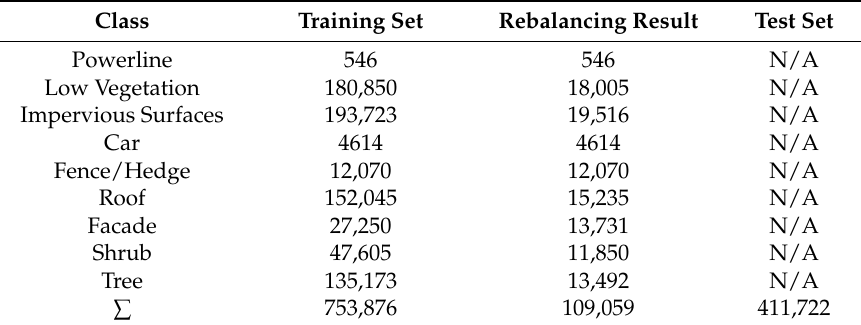
Table 2. Number of 3D points per